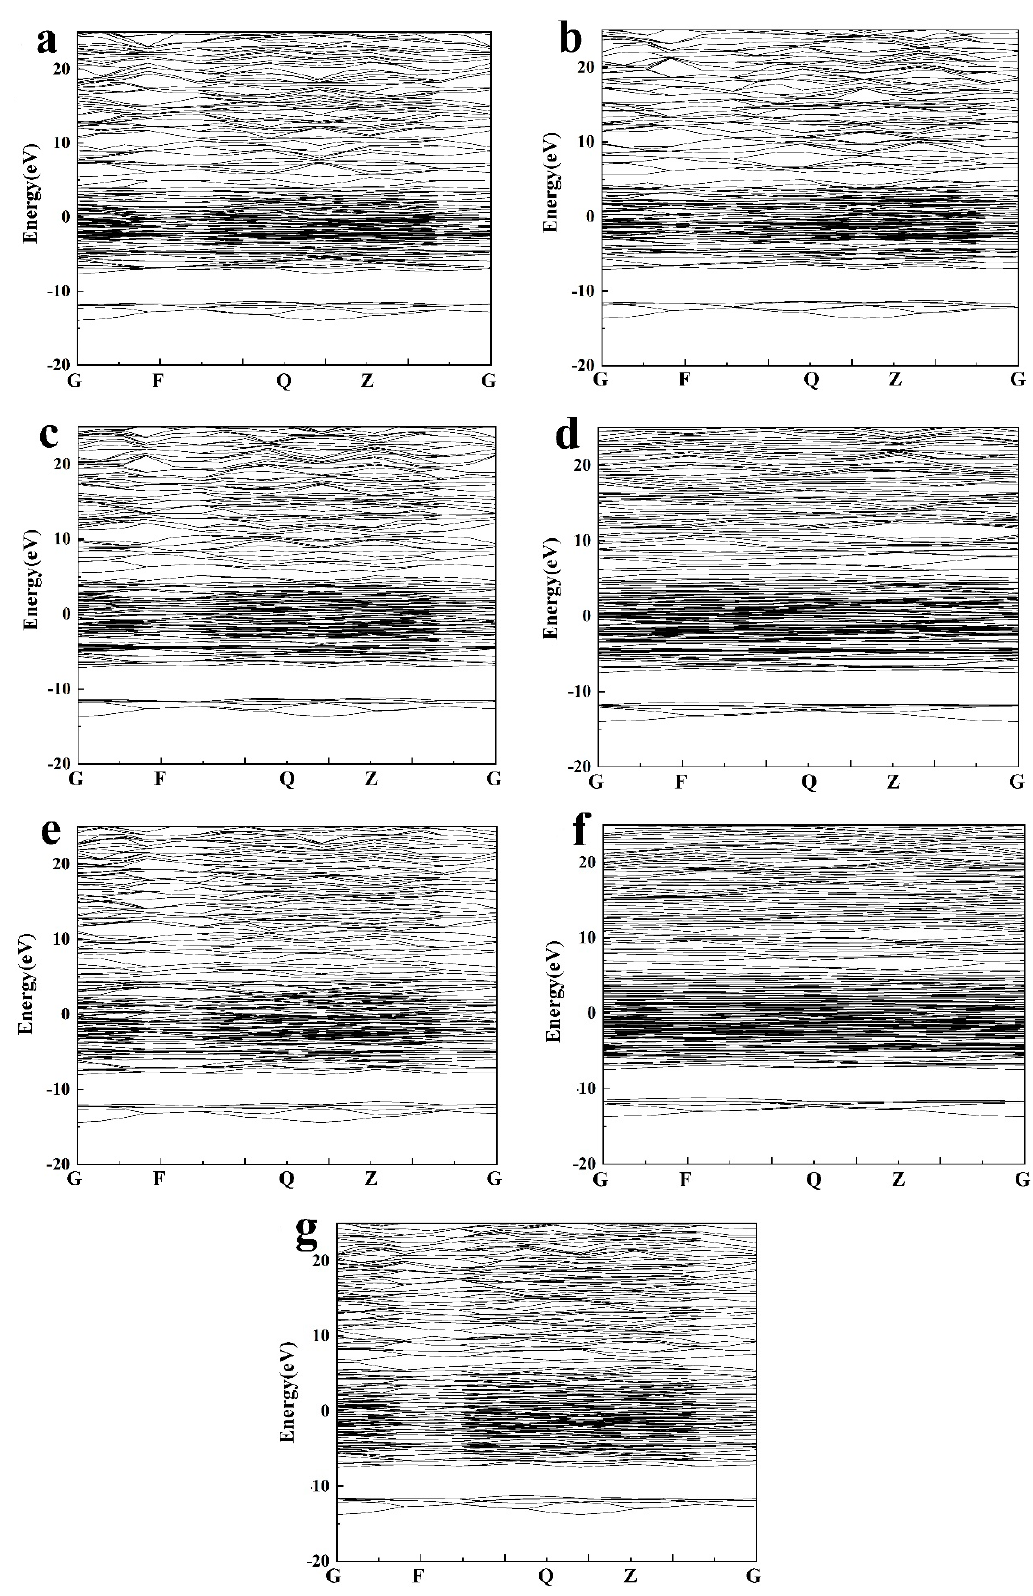
Figure 5. Calculated band structure: ( a ) Fe 5 Cr 2 C 3 ; ( b ) Fe 3 Cr 4 C 3 ; ( c ) Fe 2 Cr 5 C 3 ; ( d ) Fe 3 Cr 3.5 W 0.5 C 3 ; ( e ) Fe 3 Cr 3 W 1 C 3 ; ( f ) Fe 3 Cr 2.5 W 1.5 C 3 ; ( g ) Fe 3 Cr 2 W 2 C 3 .